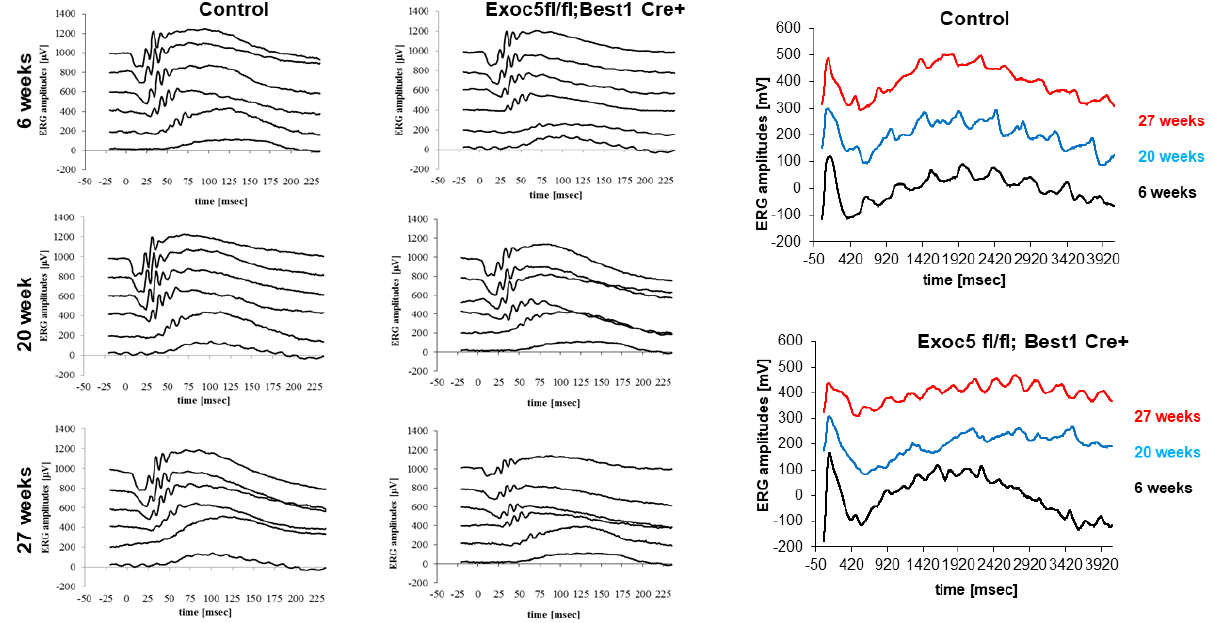
Figure 8. Measurement of visual function in Exoc5fl/fl;Best1-Cre + mice by full-field electroretinography (ERG). Dark-adapted, scotopic ERGs were recorded in response to increasing light intensities in cohorts of 6, 20, and 27-week old control ( Exoc5fl/fl ) and Exoc5fl/fl;Best1-Cre + mice. RPE-specific Exoc5 knockout mice in which both copies of Exoc5 were eliminated showed progressively significantly lower dark-adapted a - and b -wave amplitudes compared to controls (posthoc ANOVA: a -waves p < 0.03; b -waves p < 0.01), in particular at higher light intensities (20, 10, 6, 0 dB). C -waves showed an age-dependent decline in amplitude in the Exoc5 fl/fl;Best1-Cre + mice ( p = 0.002). Data are expressed as mean ± SEM ( Exoc5 fl/fl;Best1-Cre - : n = 10; and Exoc5 fl/fl;Best1-Cre + mice: n = 10).